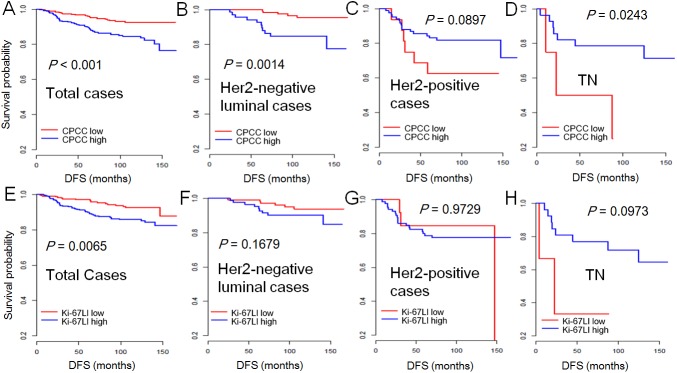
Kaplan-Meier plot for CPCC and KI-67LI in breast cancer.CPCC showed significant correlations with poor DFS in total cases (A) or HER2-negative luminal cases (B), but neither in HER2-positive (C), nor in triple-negative cases (D). Ki-67LI showed a significant correlation with poor DFS in total cases (E), but not in any subgroups such as HER2-negative luminal cases (F), HER2-positive (G), and triple-negative cases (H). The P value was determined by log-rank test. The X-axis is DFS in months, and the Y-axis, DFS probability. CPCC = chromatin CKAP2-positive cell count; Ki-67LI = Ki-67 labeling index.